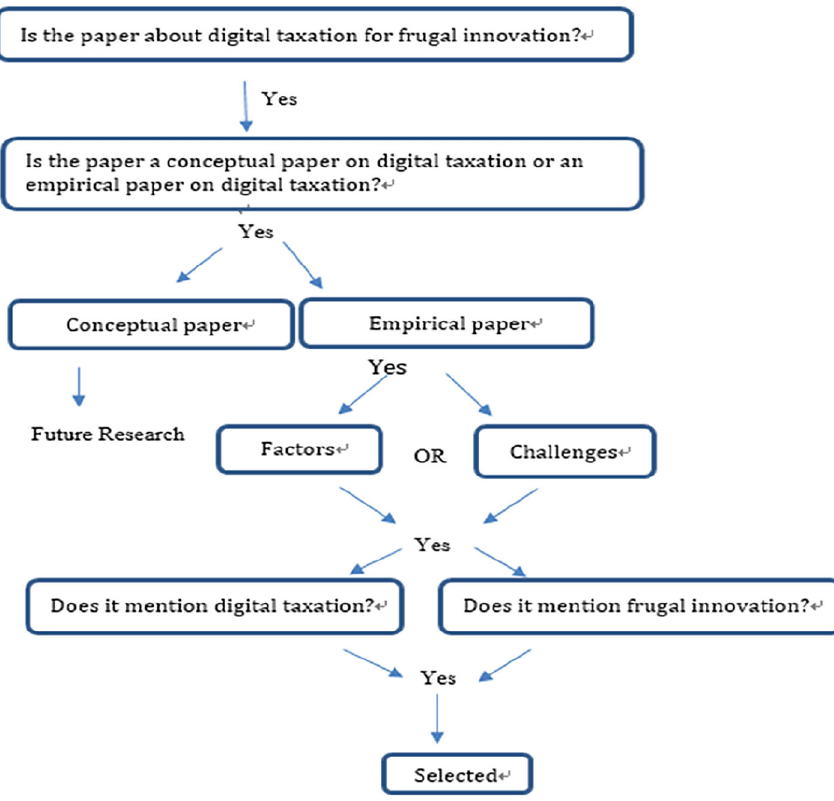
Figure 2. Extraction process.